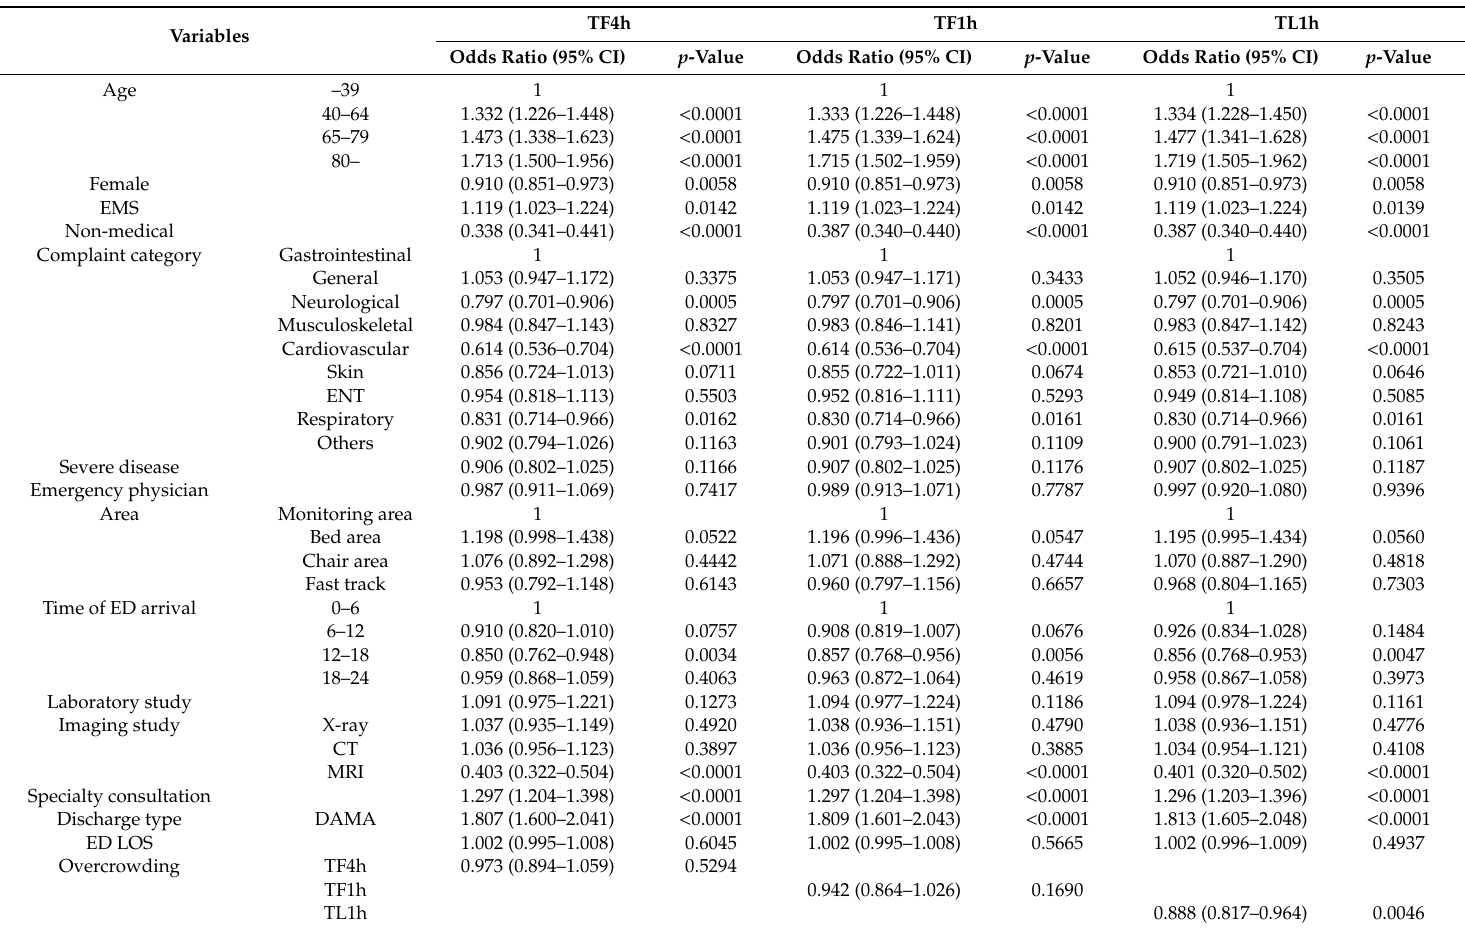
Table A2. Multivariable logistic regression of emergency department overcrowding of the number of total patients for return visit within 72